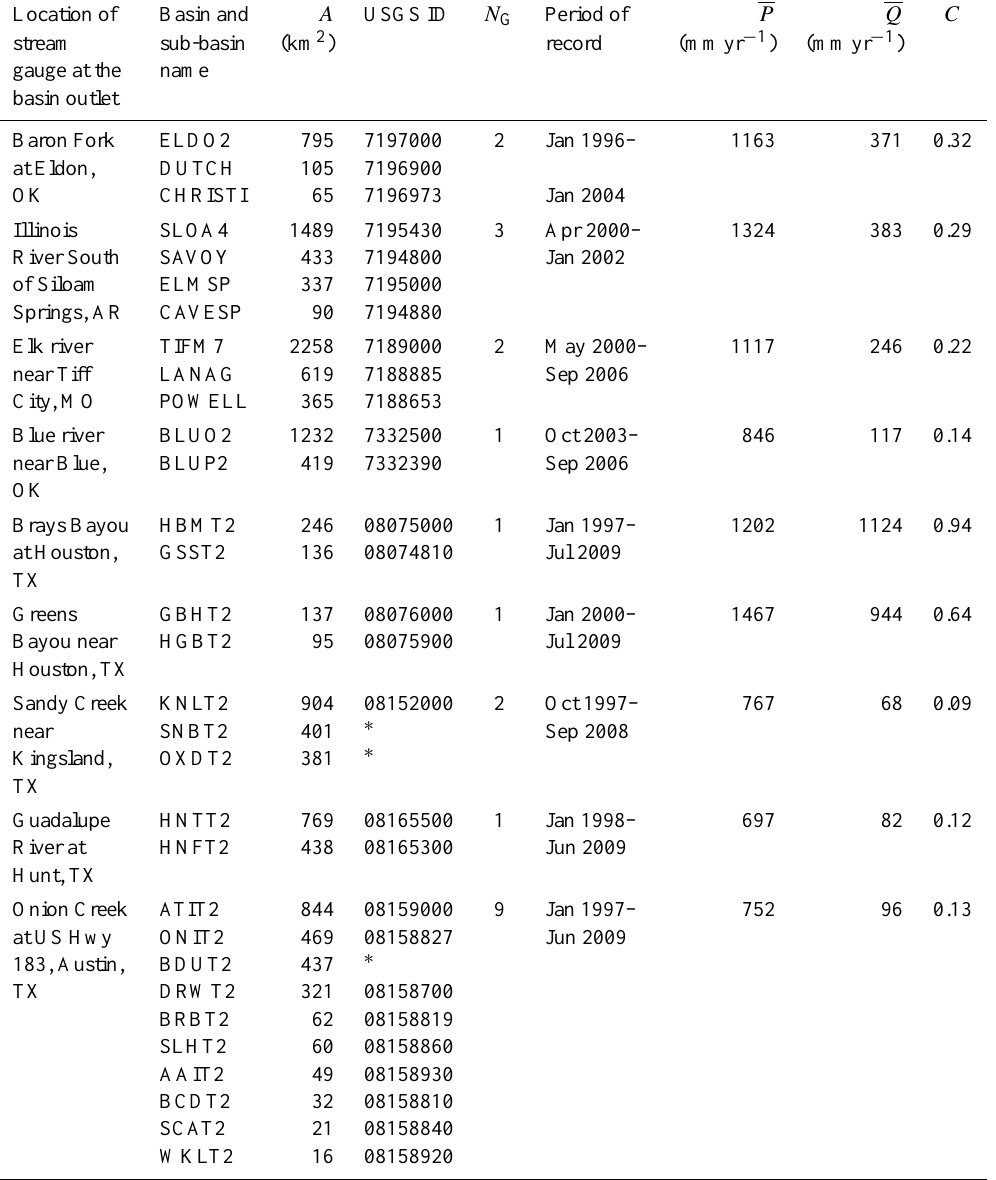
Table 1. Study basins where A denotes drainage area, N G the number of interior stream gauges in a basin, P mean annual precipitation, Q mean annual runoff, C runoff